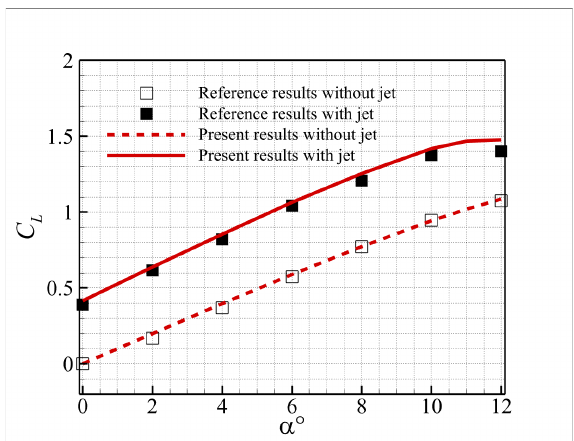
Figure 6. Comparison of the lift coefficients by the present and reference results [37].